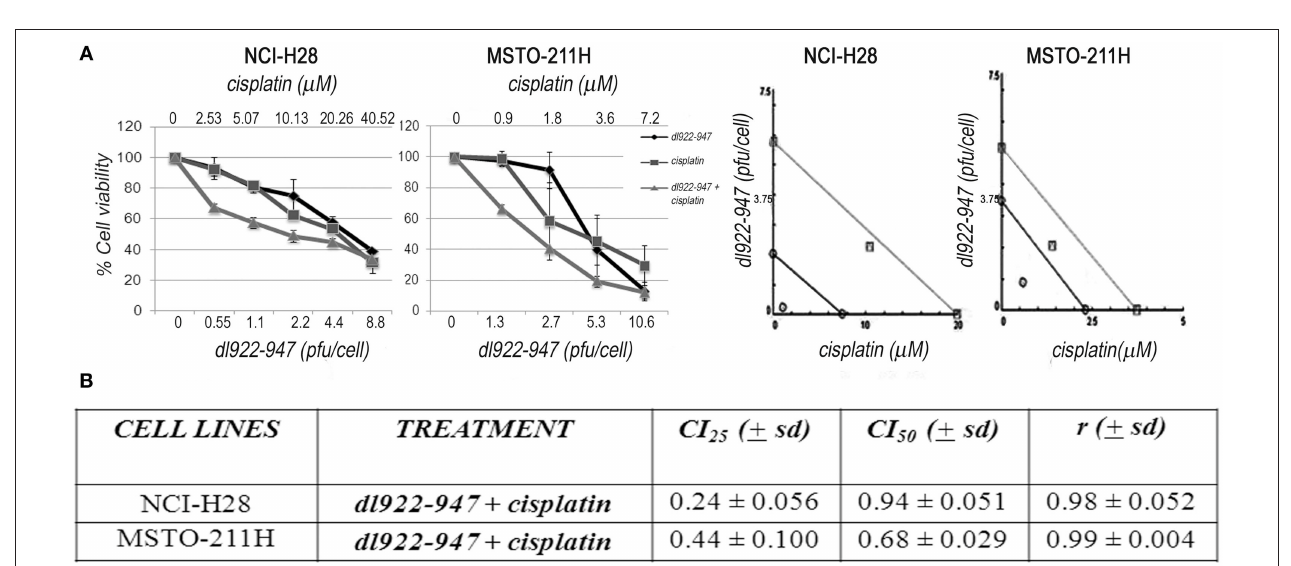
FIGURE 7 | Histological analysis of CD31 expression. Tumor mass was collected to analyze CD31 endothelial marker presence. A representative image of control and dl 922-947 treated mice is shown. The histogram reports the mean ± s.d. of TMD in tumor samples excised at day 32 treated as described above. TMD was determined as number of blood vessels x field. The statistical analysis was performed by Mann-Whitney t -test (* p < 0.05).